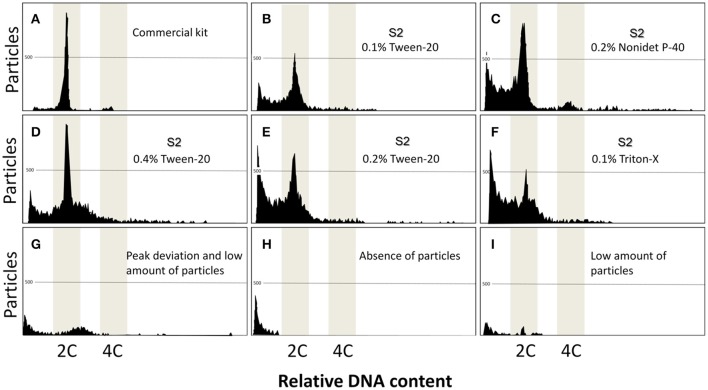
Flow cytometric charts of fin samples using various lysing treatments and staining with DAPI. A combination of five solutions, and three detergents (Triton-X, Tween-20, and Nonidet P-40 at 0.1, 0.2, and 0.4%) gave rise to 45 treatments. Additionally, a commercial kit was used as control group. Commercial kit (A) produced the clear peaks. S2 associated with Tween-20 (B,D,E), Nonidet (C) and Triton-X (F) gave some unclear peaks, demonstrating some potencial for analysis. Other treatments produced poor results including peak deviation (G), absence of particles (H), and low amount of particles (I).